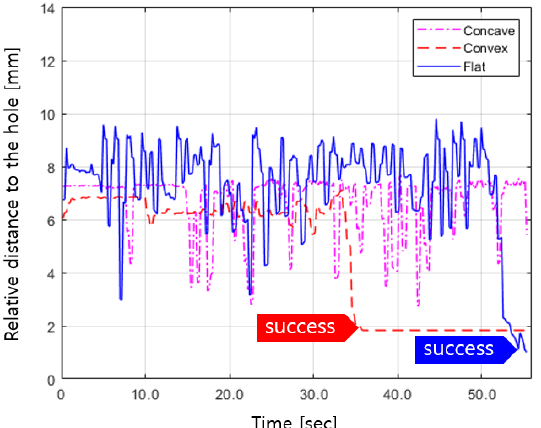
Figure 10. The comparison results of the trained robotic agent performance given the real GS cubes of the flat plane, convex plane, and the concave plane in terms of success/failure and task completion